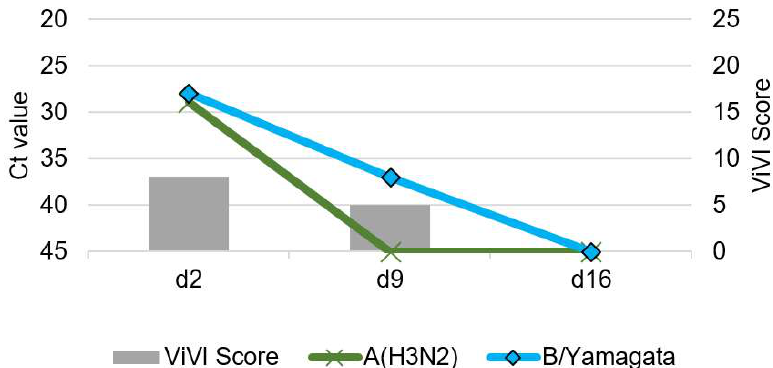
Figure 5. Patient 2 presenting with influenza B/B virus dual infection. Virus load (left inverted ver- tical axis) as approximated by Ct values correlated with ViVI Scores (right vertical axis) reflecting increasing disease severity with increasing values.